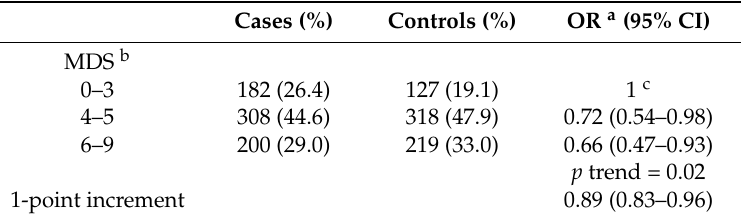
Table 2. Odds ratios (OR) and 95% confidence intervals (CI) of bladder cancer according to Mediterranean diet score (MDS) among 690 bladder cancer cases and 665 controls. Italy, 2003–2014.